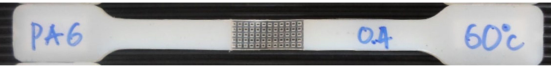
Figure 19. The PA6 material with 0.4 mm mesh thickness.